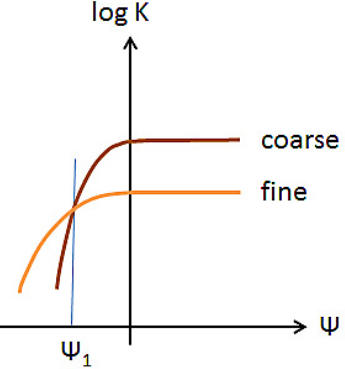
Fig. 7. Schematic relationship between hydraulic conductivity ( K ) and pressure head ( 9 ) for coarse and fine sand. By regulating the rate of rainfall such that 9 is above or well below 9 1 , it can be de- termined whether the flow will enter the coarse sand or be diverted along the bottom of the fine sand